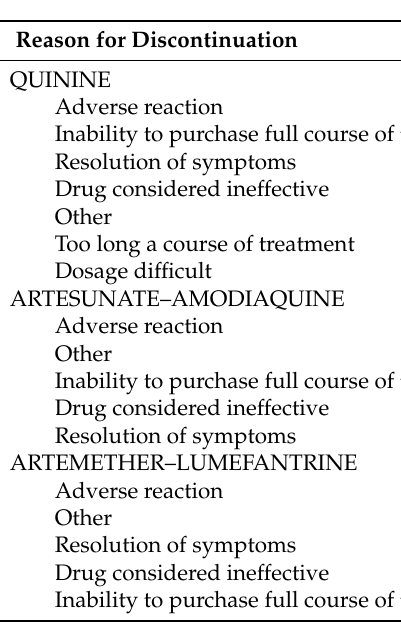
Table 4. Reason for treatment discontinuation